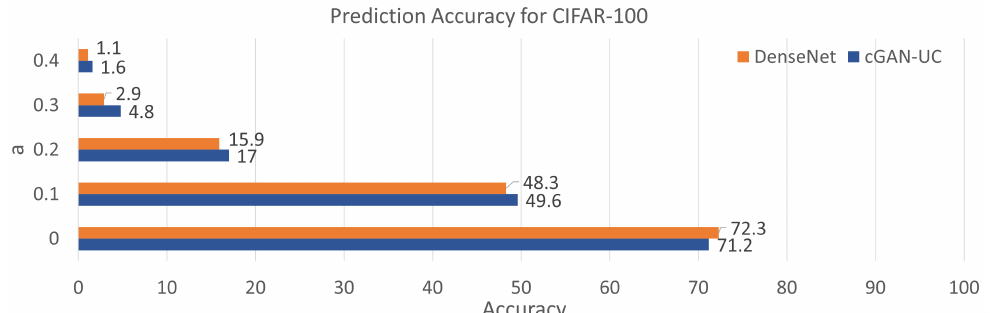
Figure 8. Prediction accuracy for the test set of CIFAR-100. The a indicates a noise